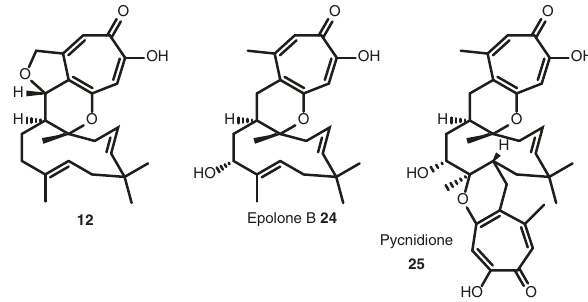
Fig. 6 Comparison between isolated xenovulene precursor 12 and known tropolone meroterpenoids 24 and 25 . The fi gure shows the structural similarities between 12 , 24 and 25